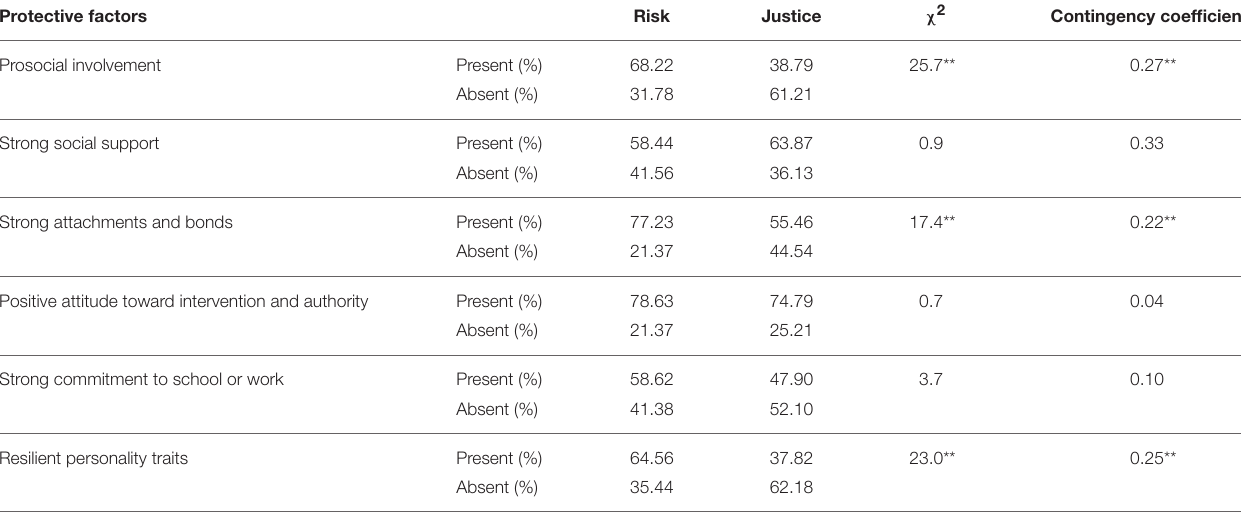
TABLE 8 | Percentage of adolescents with low, moderate, and high levels of protective factors, in juvenile justice, and risk samples. Protective